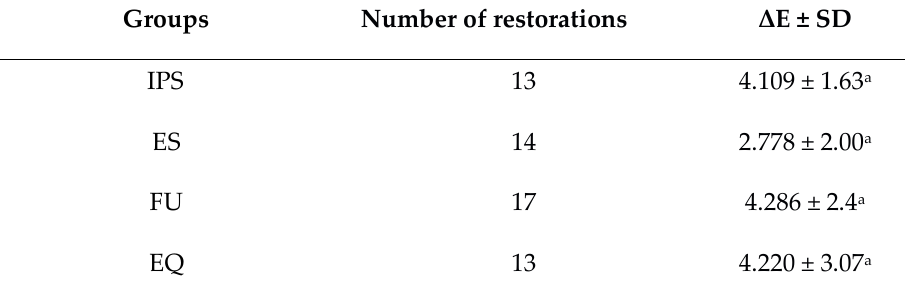
Table 1: Descriptive and statistical test of color change ΔE (Mean± SD) among composite resin groups after 1